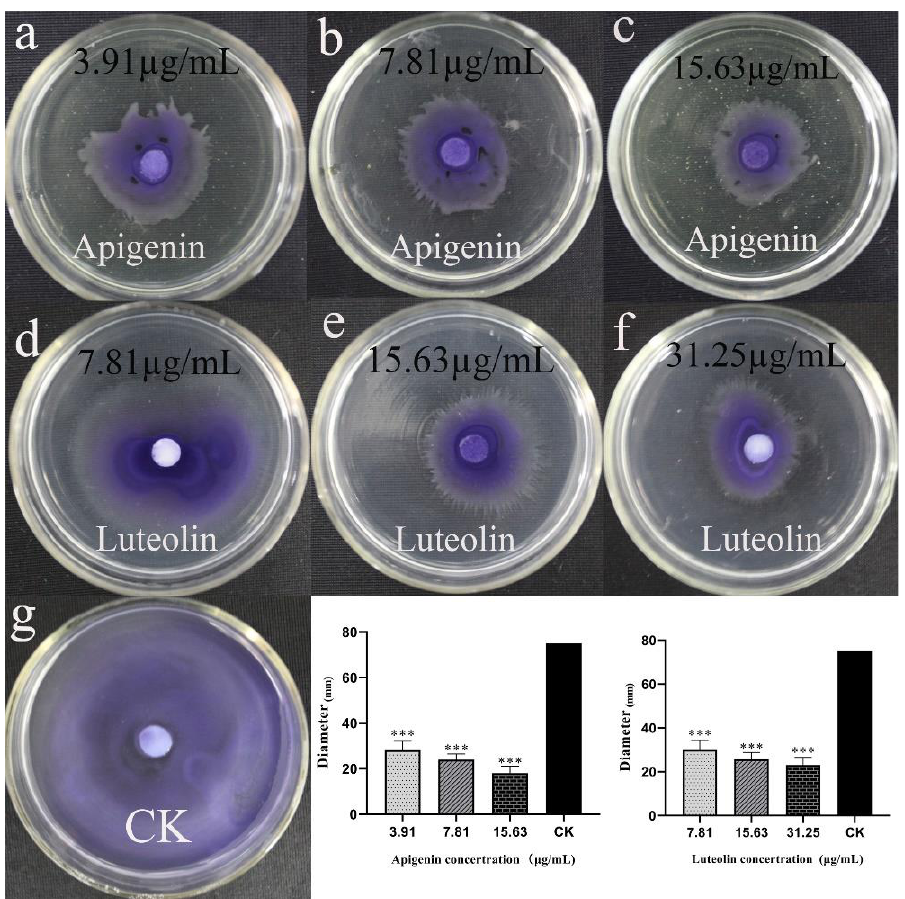
Figure 5. Effects of apigenin and quercetin on motility of C. violaceum . In the motility experiment, ( a – c ) are the apigenin treatment groups, the ( d – f ) groups are the luteolin treatment groups, and ( g ) is the control group. By comparing with the control group, as the drug concentration increases from left to right, we find that the apigenin group treatment inhibits swimming. The sexual effect changes more obviously, and the inhibitory ability of apigenin is stronger than of luteolin. Columns represent means ± standard deviation. Statistically significant differences (determined by Student ’ s t -test) are indicated as *** p < 0.001 vs. the control group. The diameter of the petri dish is 80 mm.